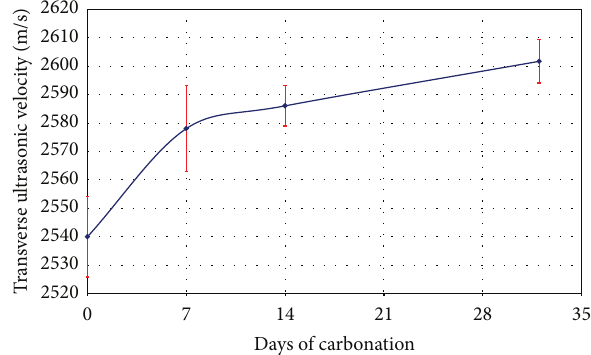
Figure 14: Evolution of the transverse ultrasonic velocity ( 𝑉 𝑇 ) during carbonation.